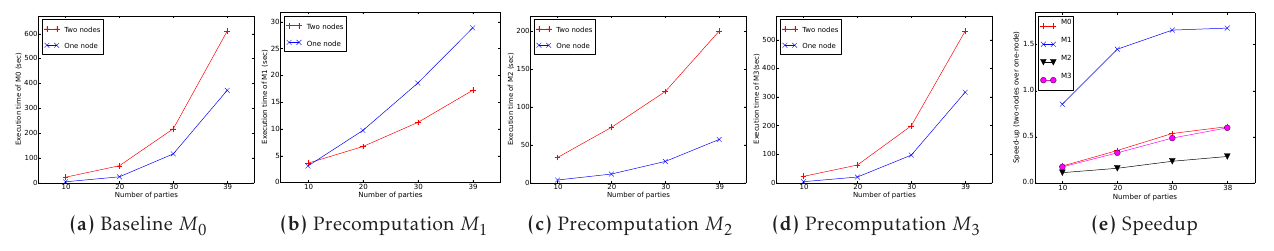
Figure 6. Geo-distributed performance on the